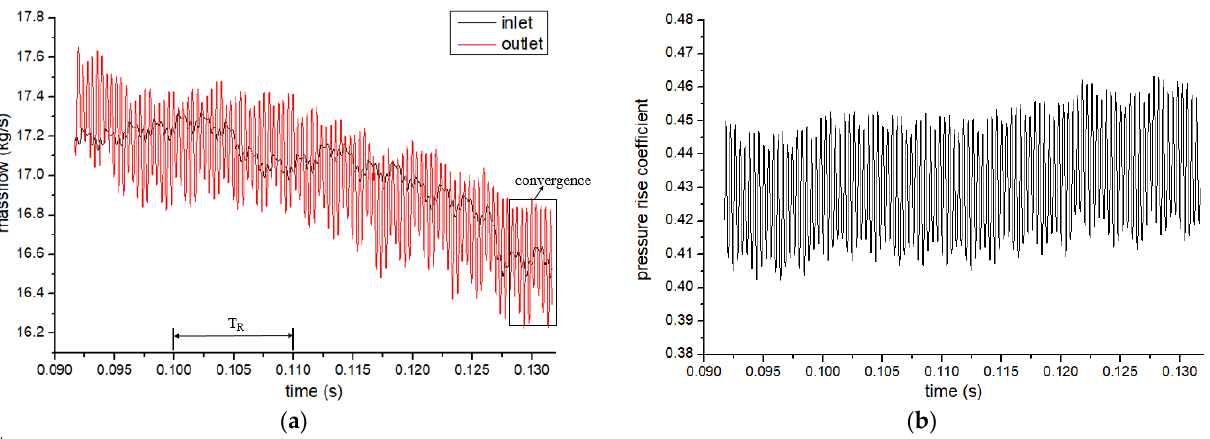
Figure 3. Parameter convergence history during unsteady simulation. ( a ) Mass flow-rate signal and ( b ) pressure-rise coefficient signal. ( b ) pressure-rise coefficient